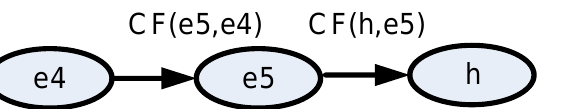
Figure 8. IQ model for the example without double traffic lights (the authors’ own study). Forwarding information with redundancy (Figure 9).